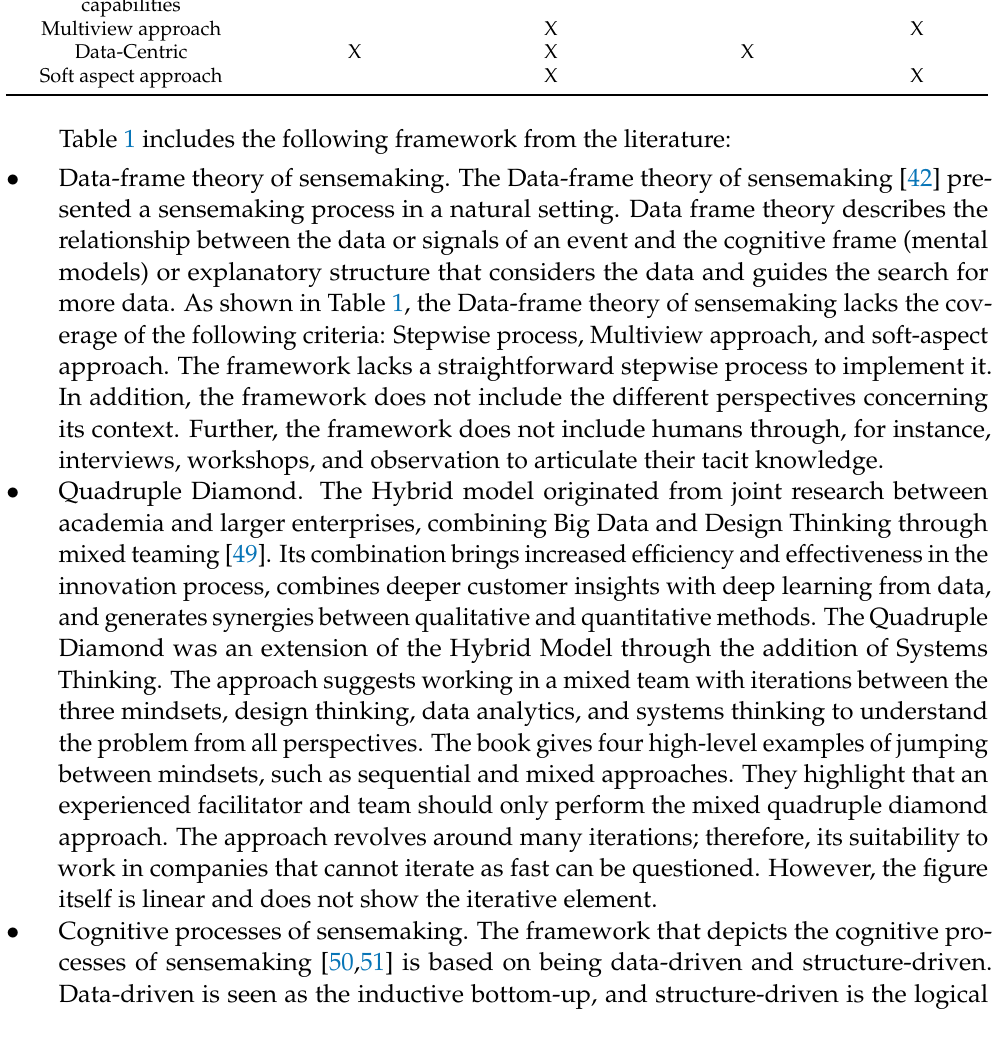
Table 1 includes the following framework from the